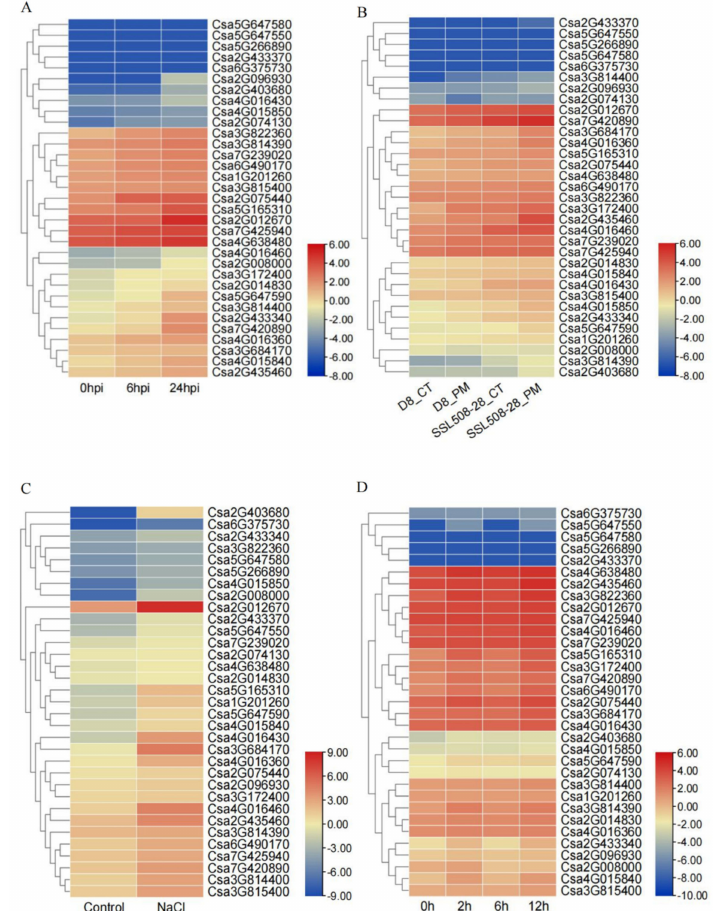
Figure 6. The expression patterns of the CNL genes under biotic and abiotic stresses in cucumber plants. ( A ) The expression of cucumber CNL genes in response to DM, post-inoculation at 0 h, 6 h, and 24 h. ( B ) The expression of cucumber CNL genes in response to PM, post-inoculation at 0 h, and 48 h. D8_CT, D8 line control; D8_PM, D8 line, 48 h post-inoculation with PM; SSL508-28_CT, SSL508-28 line as control; SSL508-28_PM, SSL508-28 line, 48 h post-inoculation with PM. ( C ) and ( D ) The expression of cucumber CNL genes in response to salt stress and chilling stresses. Hpi, hours post-inoculation. The genome-wide expression of CsCNL genes were shown on a heatmap using log 2 RPKM value, and − 8.00 to 6.00, − 9.00 to 9.00, − 10.00 to 6.00 were artificially set with the color scale limits according to the normalized value. The color scale was shown increasing expression levels from blue to